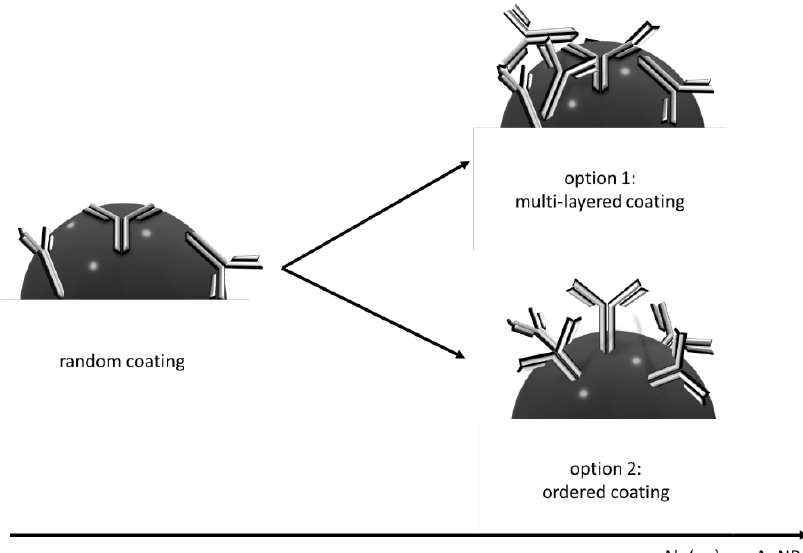
Figure 2. Scheme of the hypothesized increase in mAb adsorbed onto AuNP: ( 1 ) absorption of a second layer of randomly oriented mAb; ( 2 ) the additional mAb forced the head-on/tail-on orienta-